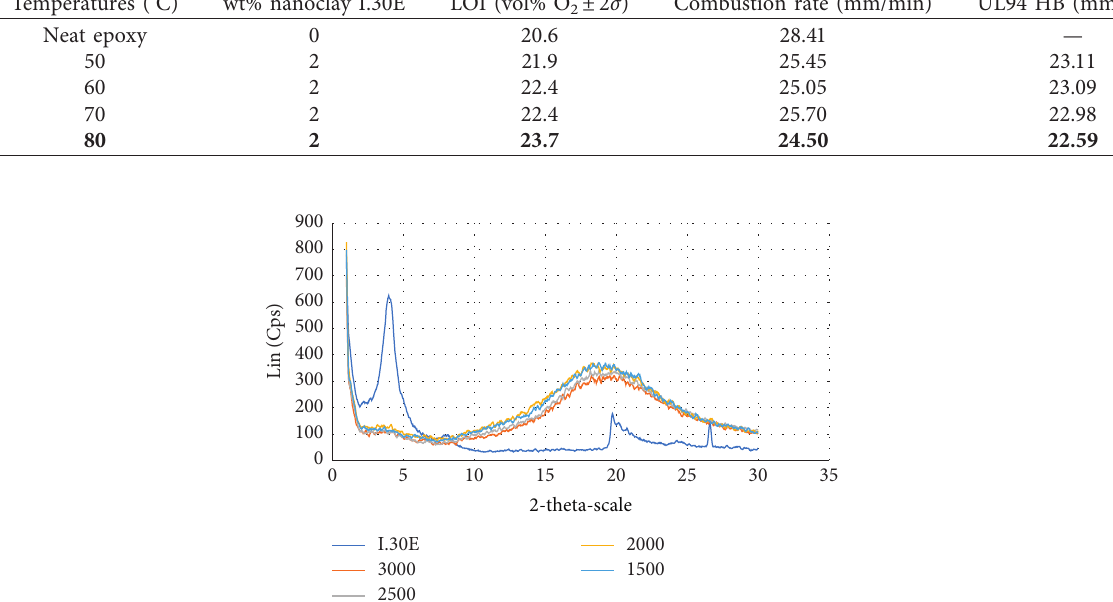
Table 4: Effect of temperature during mechanical stirring on fire retardancy of epoxy Epikote 240/nanoclay I.30E nanocomposite materials. No.